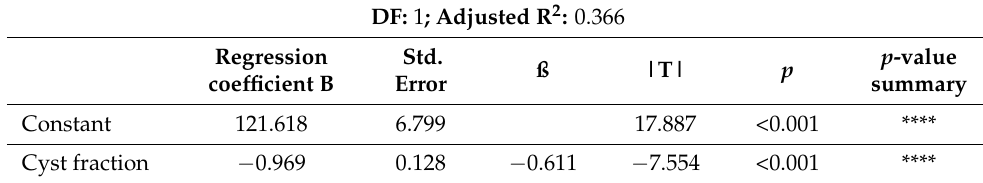
Table 2. Univariate linear regression analysis of subcohort year 1. eGFR served as the dependent variable, while the cyst fraction, or log htTKV, acted as the independent variable. eGFR, estimated glomerular filtration rate; DF, degrees of freedom; htTKV, height-adjusted total kidney volume. Model I: eGFR ~ log